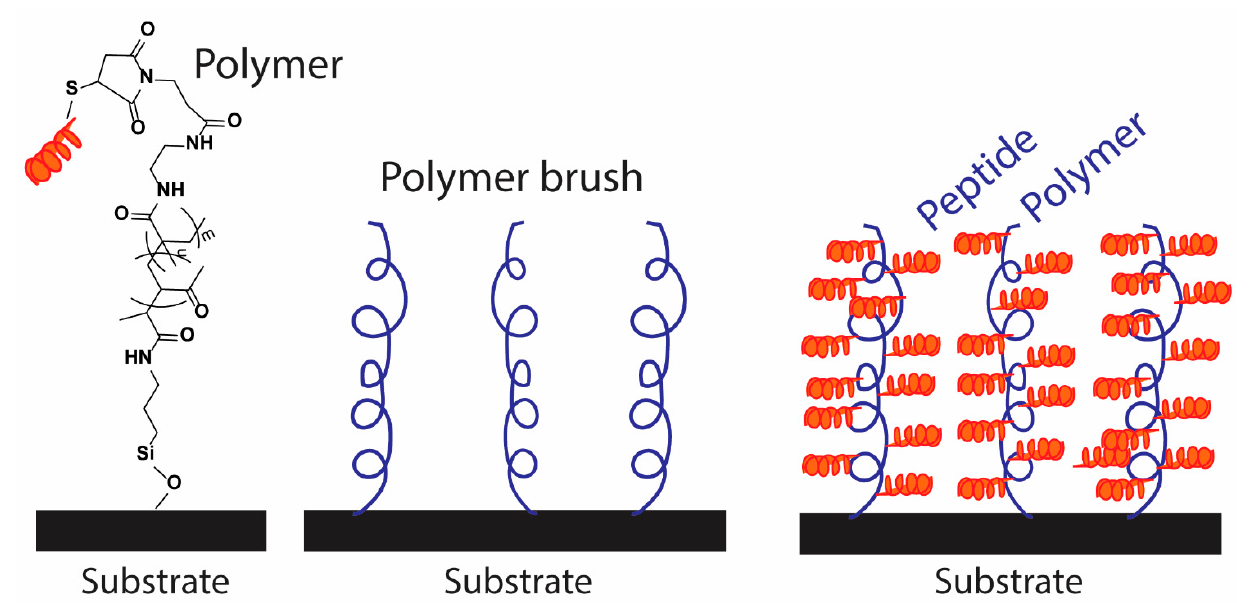
Figure 9. Representation of polymer brush integrated HDP on a substrate.